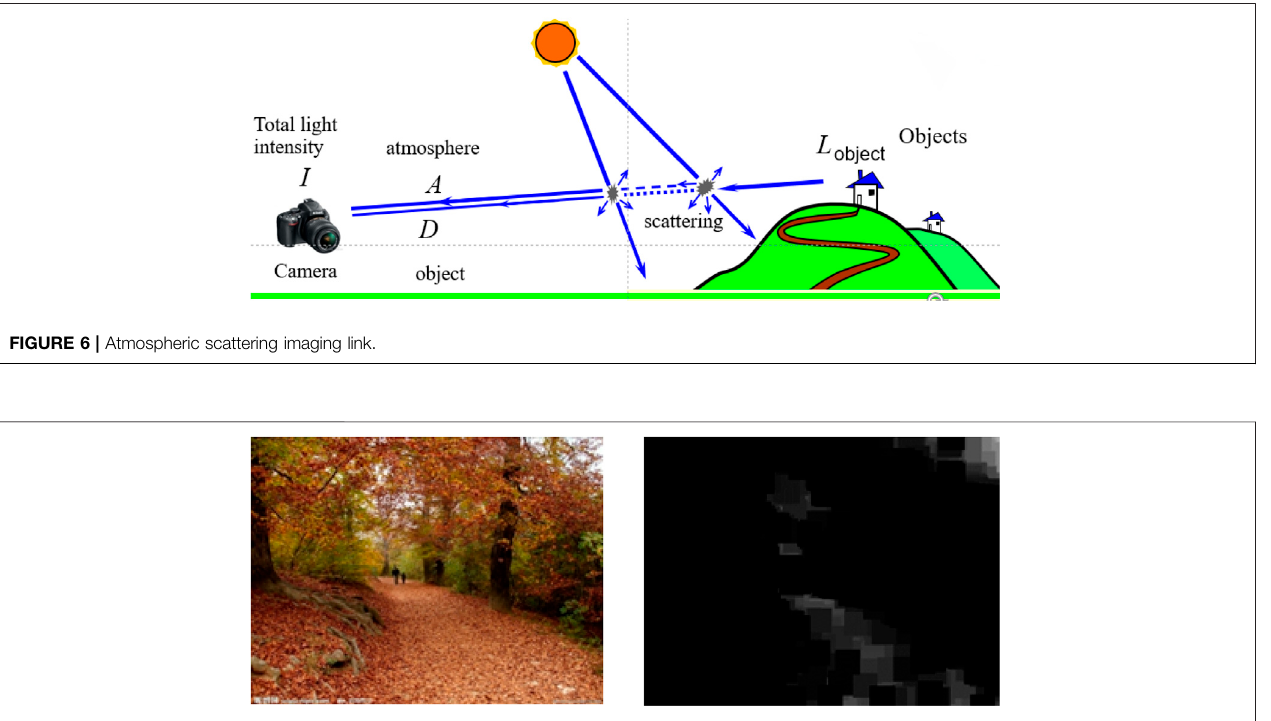
FIGURE 7 | Clear image and dark channel